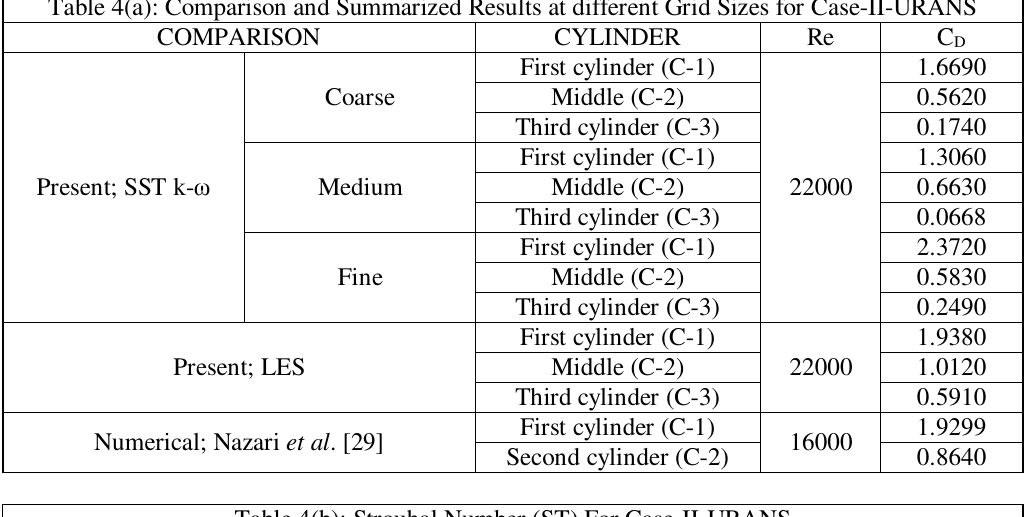
Table 4(b): Strouhal Number (ST) For